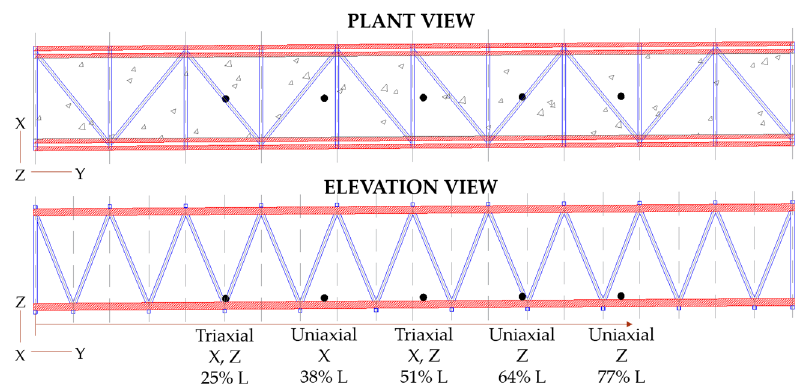
Figure 9. Experimental setup (location of accelerometers).